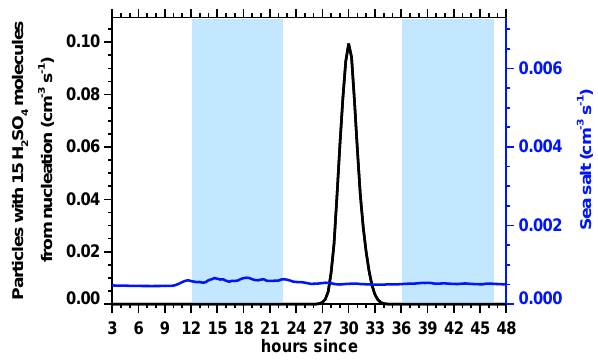
Fig. 7. Formation rate of particles containing 15 H 2 SO 4 molecules from aerosol nucleation (black), and emissions of sea salt particles (blue) from simulation S 0 , averaged over the boundary layer. Light blue shading indicates nighttime. Nucleation takes place only dur- ing the second day of the simulation, after the transition from closed to open